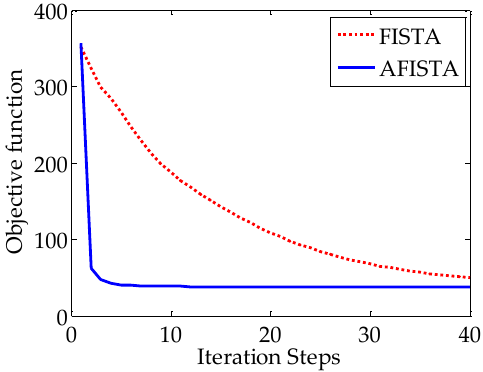
Figure 2. The value of objective function in terms of iteration steps of the proposed AFISTA methods and FISTA for the brain image phantom with 5 × 10 4 incident photon and FISTA for the brain image phantom with 5 × 10 4 incident photon numbers.